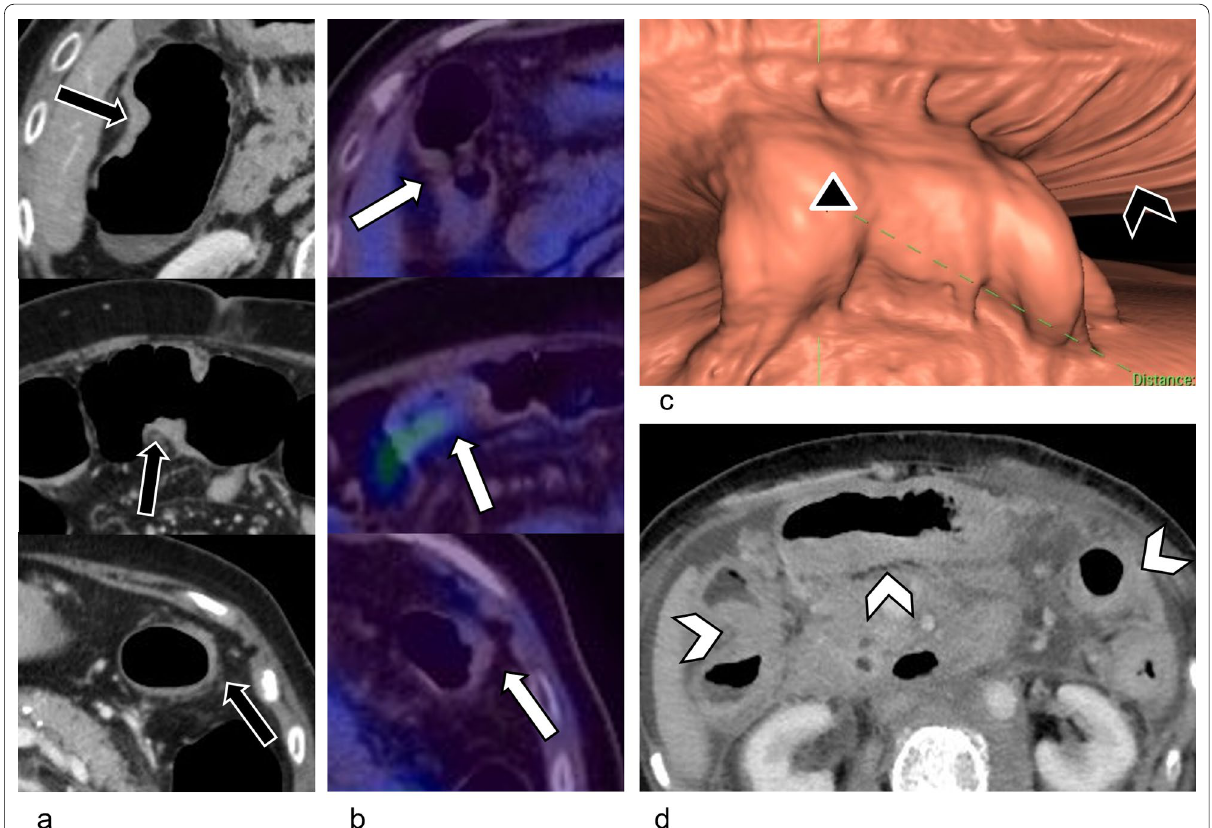
Fig. 6 Metastatic ILC of the colon in a 77-year-old female with recurrent episodes of subacute intestinal obstruction over 6 months. She had completed therapy for Stage 3A ILC more than 10 years ago. a Axial contrast-enhanced CT colonography shows focal segments of smooth, mural thickening (black arrows) in the hepatic flexure (top), transverse colon (middle), and descending colon (bottom), mimicking peristalsis. No discrete mass is seen. b 18 F-FDG PET/CT scan performed shortly after demonstrates that these segments of mural thickening in the colon (white arrows) have minimal 18 F-FDG-uptake. c Reconstructed CT colonography virtual dissection image shows that the normal haustra of the hepatic flexure (black arrowhead) is disrupted by abnormal, focal mural thickening (∆), confirming that it is pathological. d Axial contrast-enhanced CT 1 year later shows progression of metastatic disease involving the hepatic flexure, transverse colon, and descending colon (white